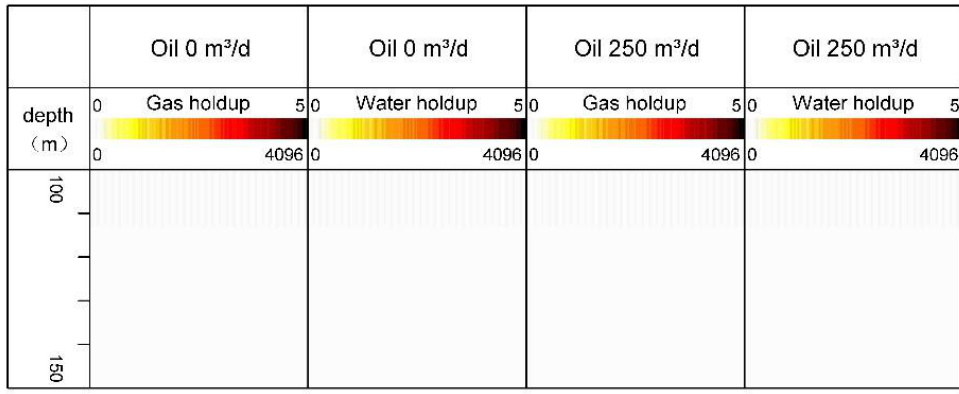
Figure 4. Response characteristics of pure oil at 0 and 250 m 3 /d.